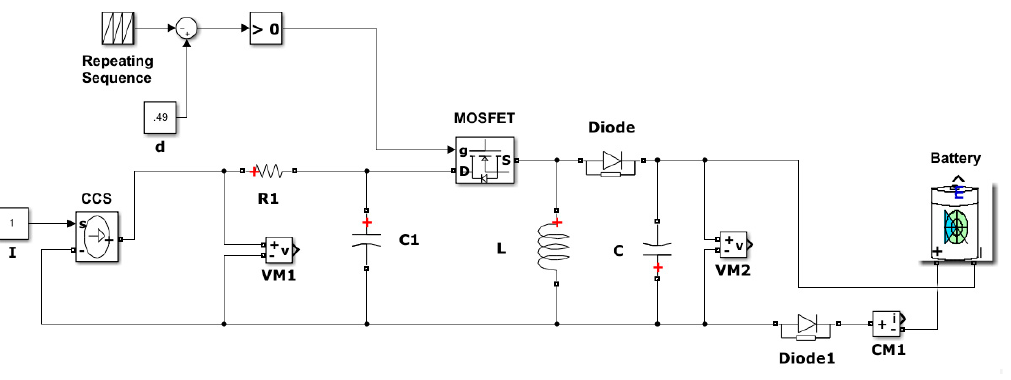
Figure 7. Simulation diagram of buck–boost converter.